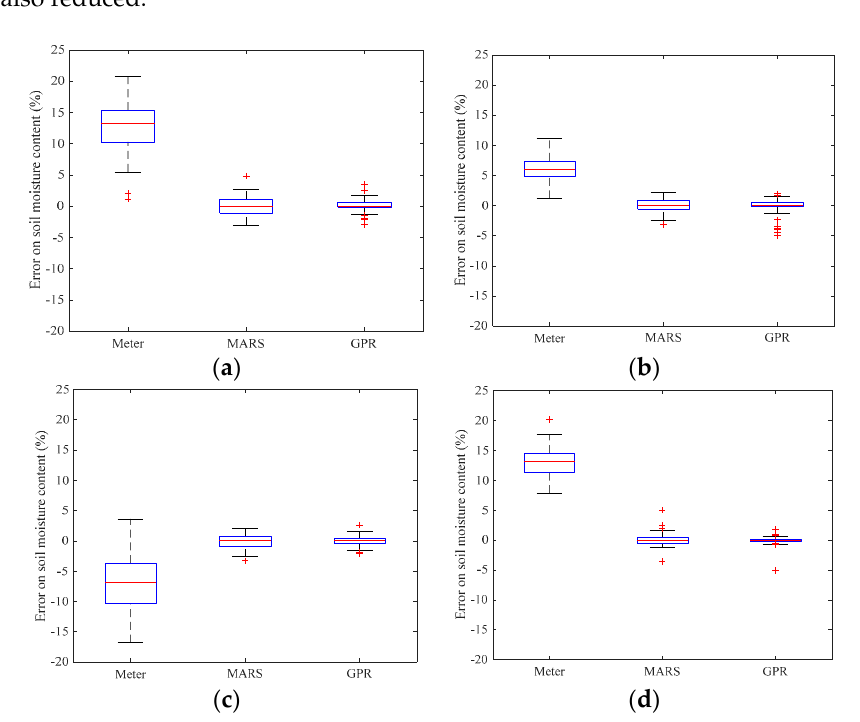
( d ) Figure 4. The comparison of soil moisture content by different approaches: ( a ) sensor A; ( b ) sensor B; ( c ) sensor C; and ( d ) sensor D. From the above analysis, the proposed data-driven calibration of soil moisture sensors considering the impact of temperature can greatly improve the accuracy of soil moisture content measurement. The MARS and GPR model were used due to their strong capability in nonlinear